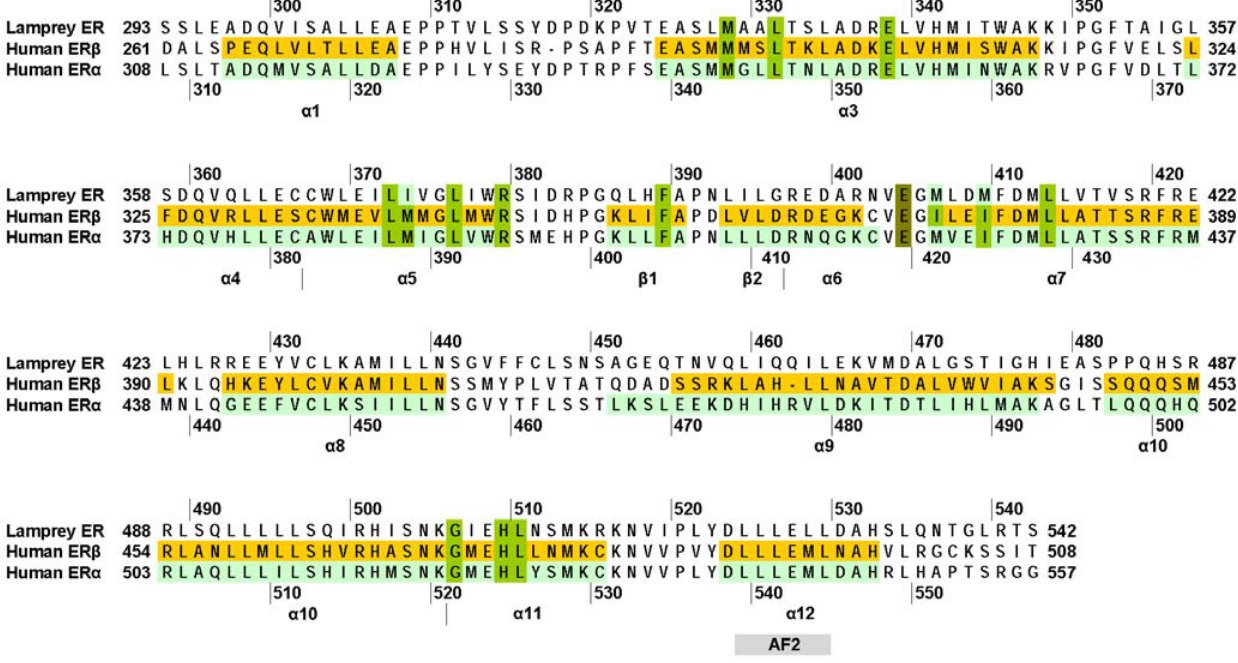
Figure 2. Alignment of lamprey ER with human ER a and human ER b . a -helices and b -strands from the crystal structures of ER a and ER b are shaded in each sequence and notated below the alignment. Residues in human ER a involved in binding of estradiol are shown in green. Glu-419, which stabilizes His-524 is shaded in brown. Crystal structure accessions are human ER a [PDB: 1G50], human ER b [1QKM].